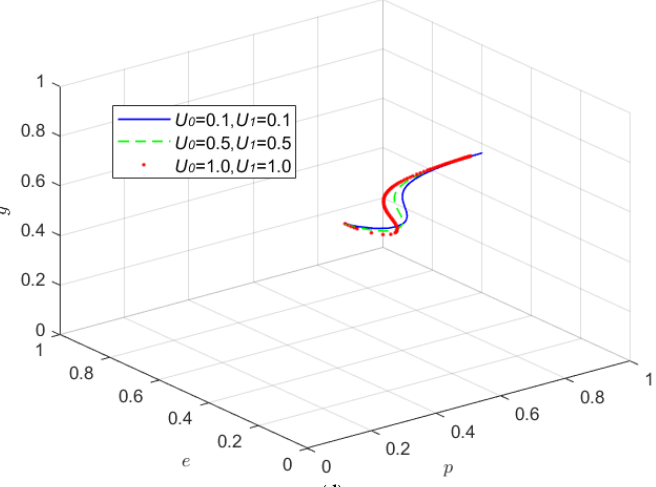
Figure 4. ( a ) Influence of reference points on system evolution under static reward and static penalty systems. ( b ) Influence of reference points on system evolution under dynamic reward and static penalty systems. ( c ) Influence of reference points on system evolution under static reward and dynamic penalty systems. ( d ) Influence of reference points on system evolution under dynamic reward and dynamic penalty systems.